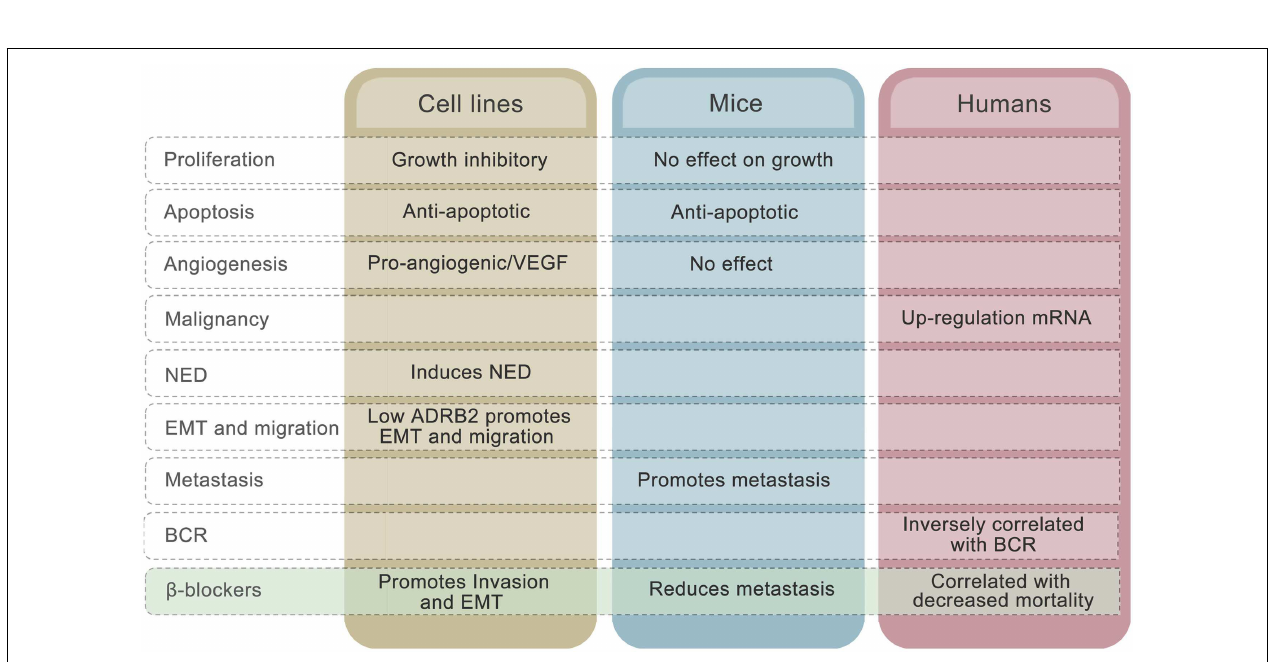
FIGURE 2 | Hypothetical model of how β 2 -adrenergic signaling may promote progression of prostate cancer . In summary, we hypothesize that ADRB2s expressed on luminal cells are activated by catecholamines, which are secreted by nerves and transported through blood vessels in response to stress. Catecholamines are possibly also secreted by proximal chromaffin-like cells and macrophages (not shown) that also can produce epinephrine and norepinephrine, respectively. In addition, ADRB2s expressed on stromal cells are activated by sympathetic stimuli. Upon ligand-binding, the expression of anti-apoptotic and pro-angiogenic factors is